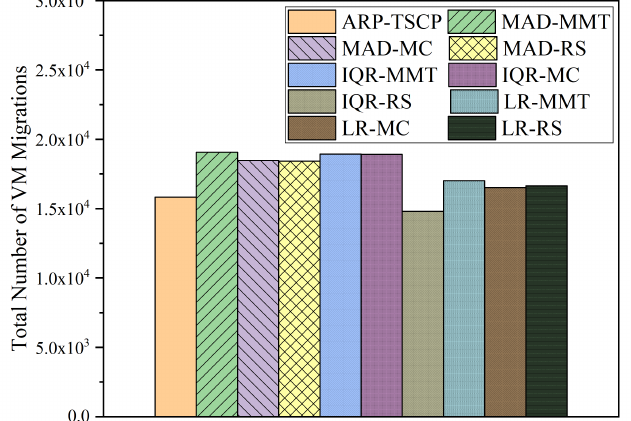
Figure 15. Comparing the total number of VM migrations triggered by all